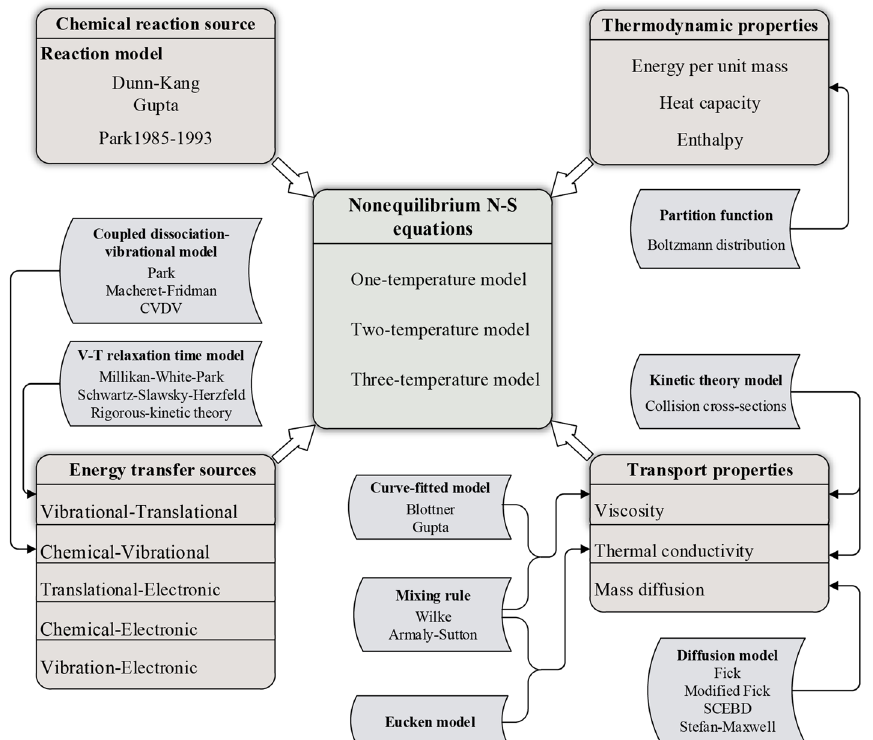
Fig. 5 Diagram of the calculation process of the CFD method for nonequilibrium